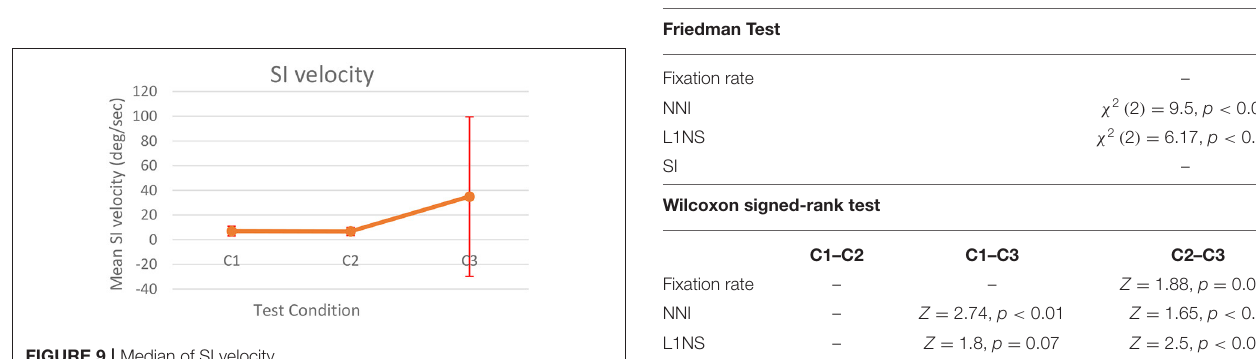
FIGURE 9 | Median of SI velocity.